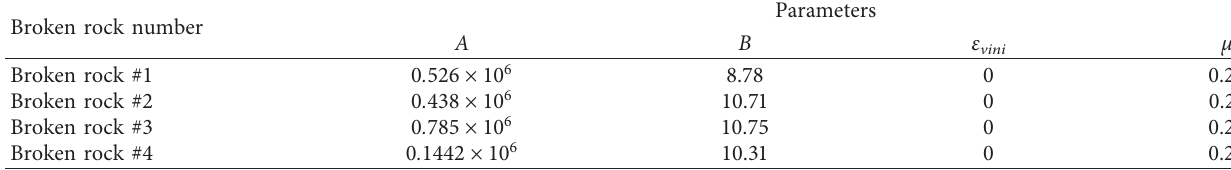
Figure 4: Numerical calculation model. Table 1: Material parameters of the filling